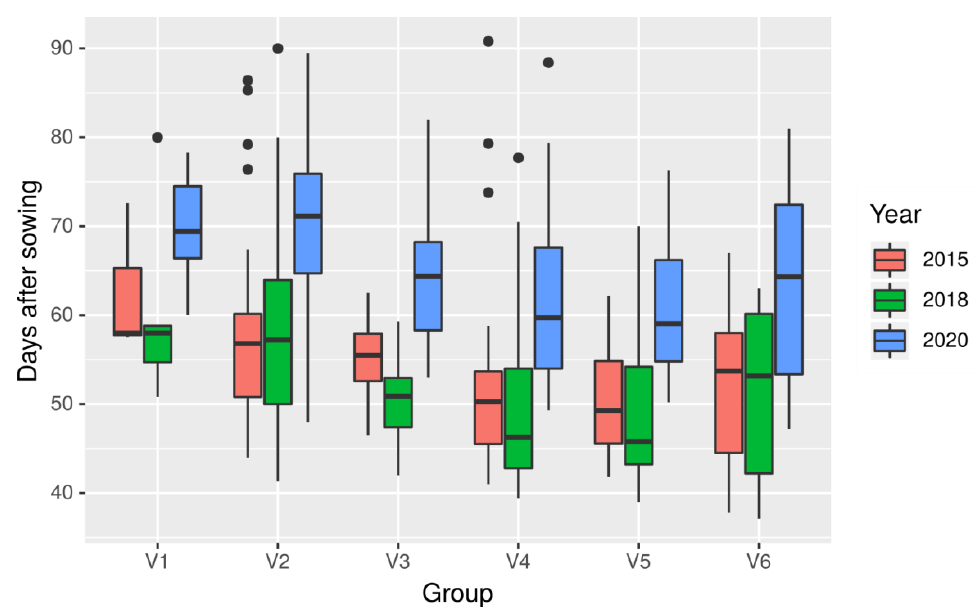
Figure 5. Box plot of days to flowering observed in 6 white lupin subpopulations.